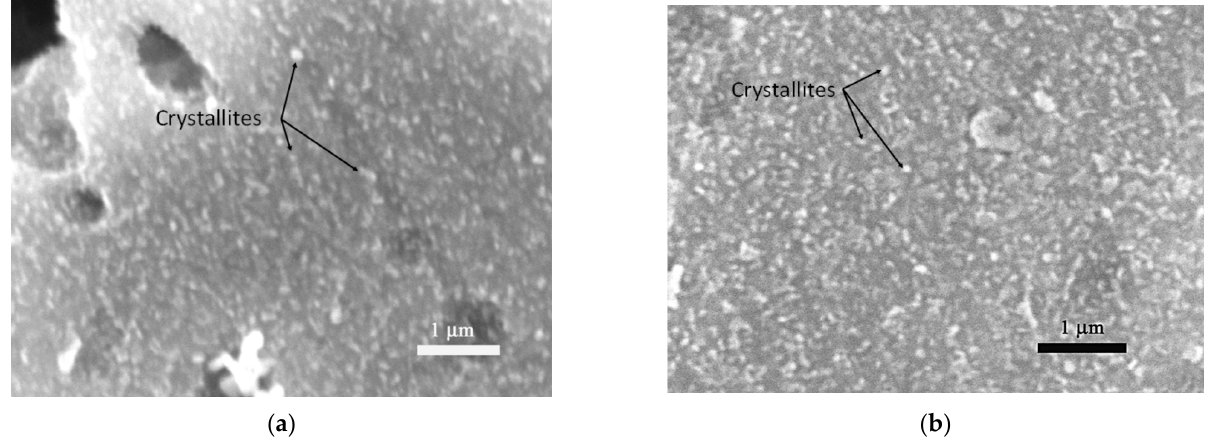
Metals 2021 , 11 , x FOR PEER REVIEW Figure 7. ( a ) SEM image of the 300/0s sample microstructure. ( b ) SEM image of the 300/1s sample microstructure. Figure 7. ( a ) SEM image of the 300/0s sample microstructure. ( b ) SEM image of the 300/1s sample microstructure. Figure 7. ( a ) SEM image of the 300/0s sample microstructure. ( b ) SEM image of the 300/1s sample microstructure.